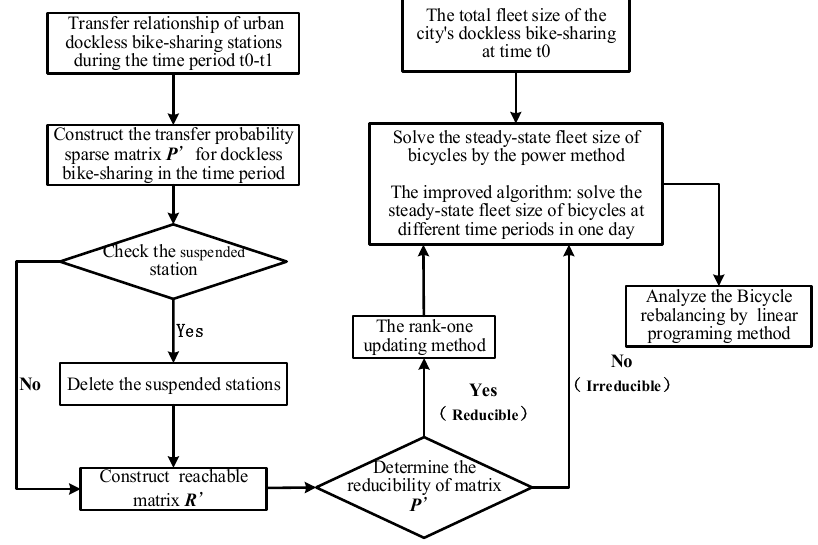
Figure 4. Fleet size and rebalancing analysis of dockless bike-sharing stations framework.